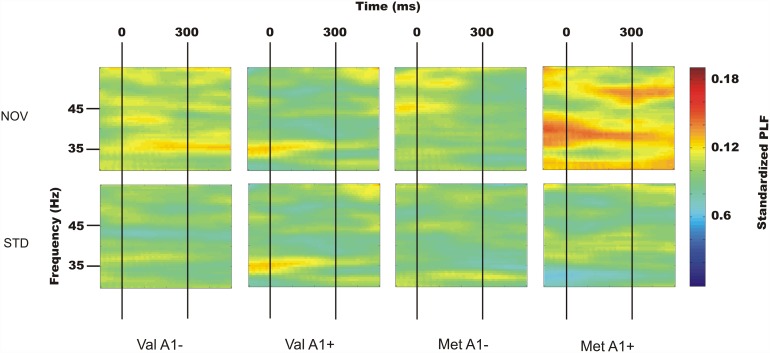
Standardized PLF values for novel and standard trials.Plots of standardized PLF values for novel and standard trials are shown for all four groups’ Cz for frequencies from 30 to 55 Hz. ValA1- and MetA1+ groups showed enhanced PLF in novel compared to standard trials around 100 ms post-sound onset, whereas ValA1+ and MetA1- groups had similar PLF values to both stimulus types.